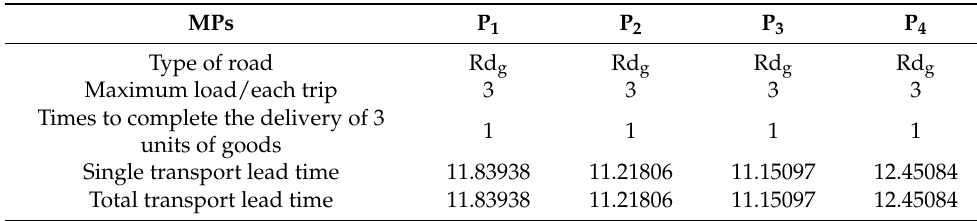
Table 7. Transport lead time on Rd g